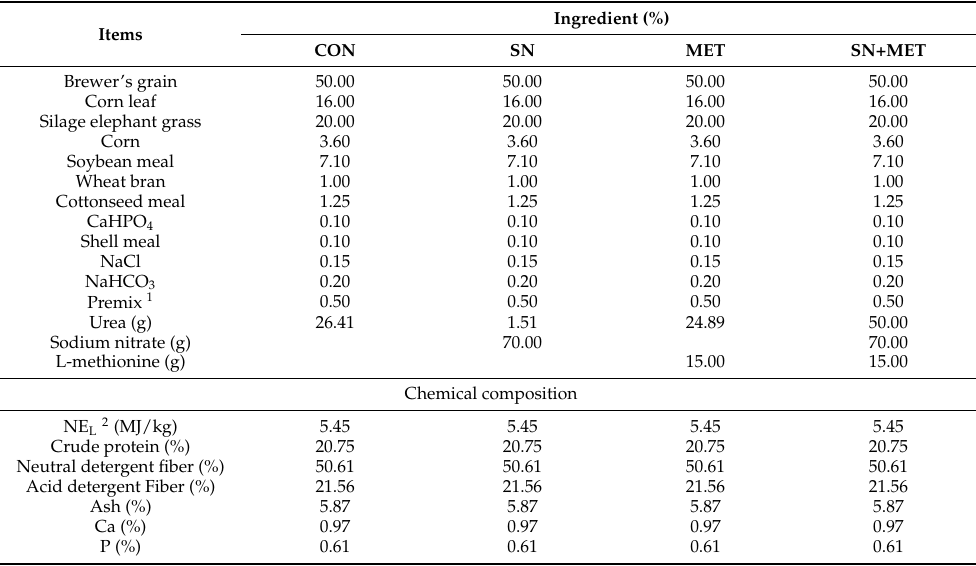
Table 1. Major ingredients and chemical composition of the experimental basal feed substrate based on dry matter